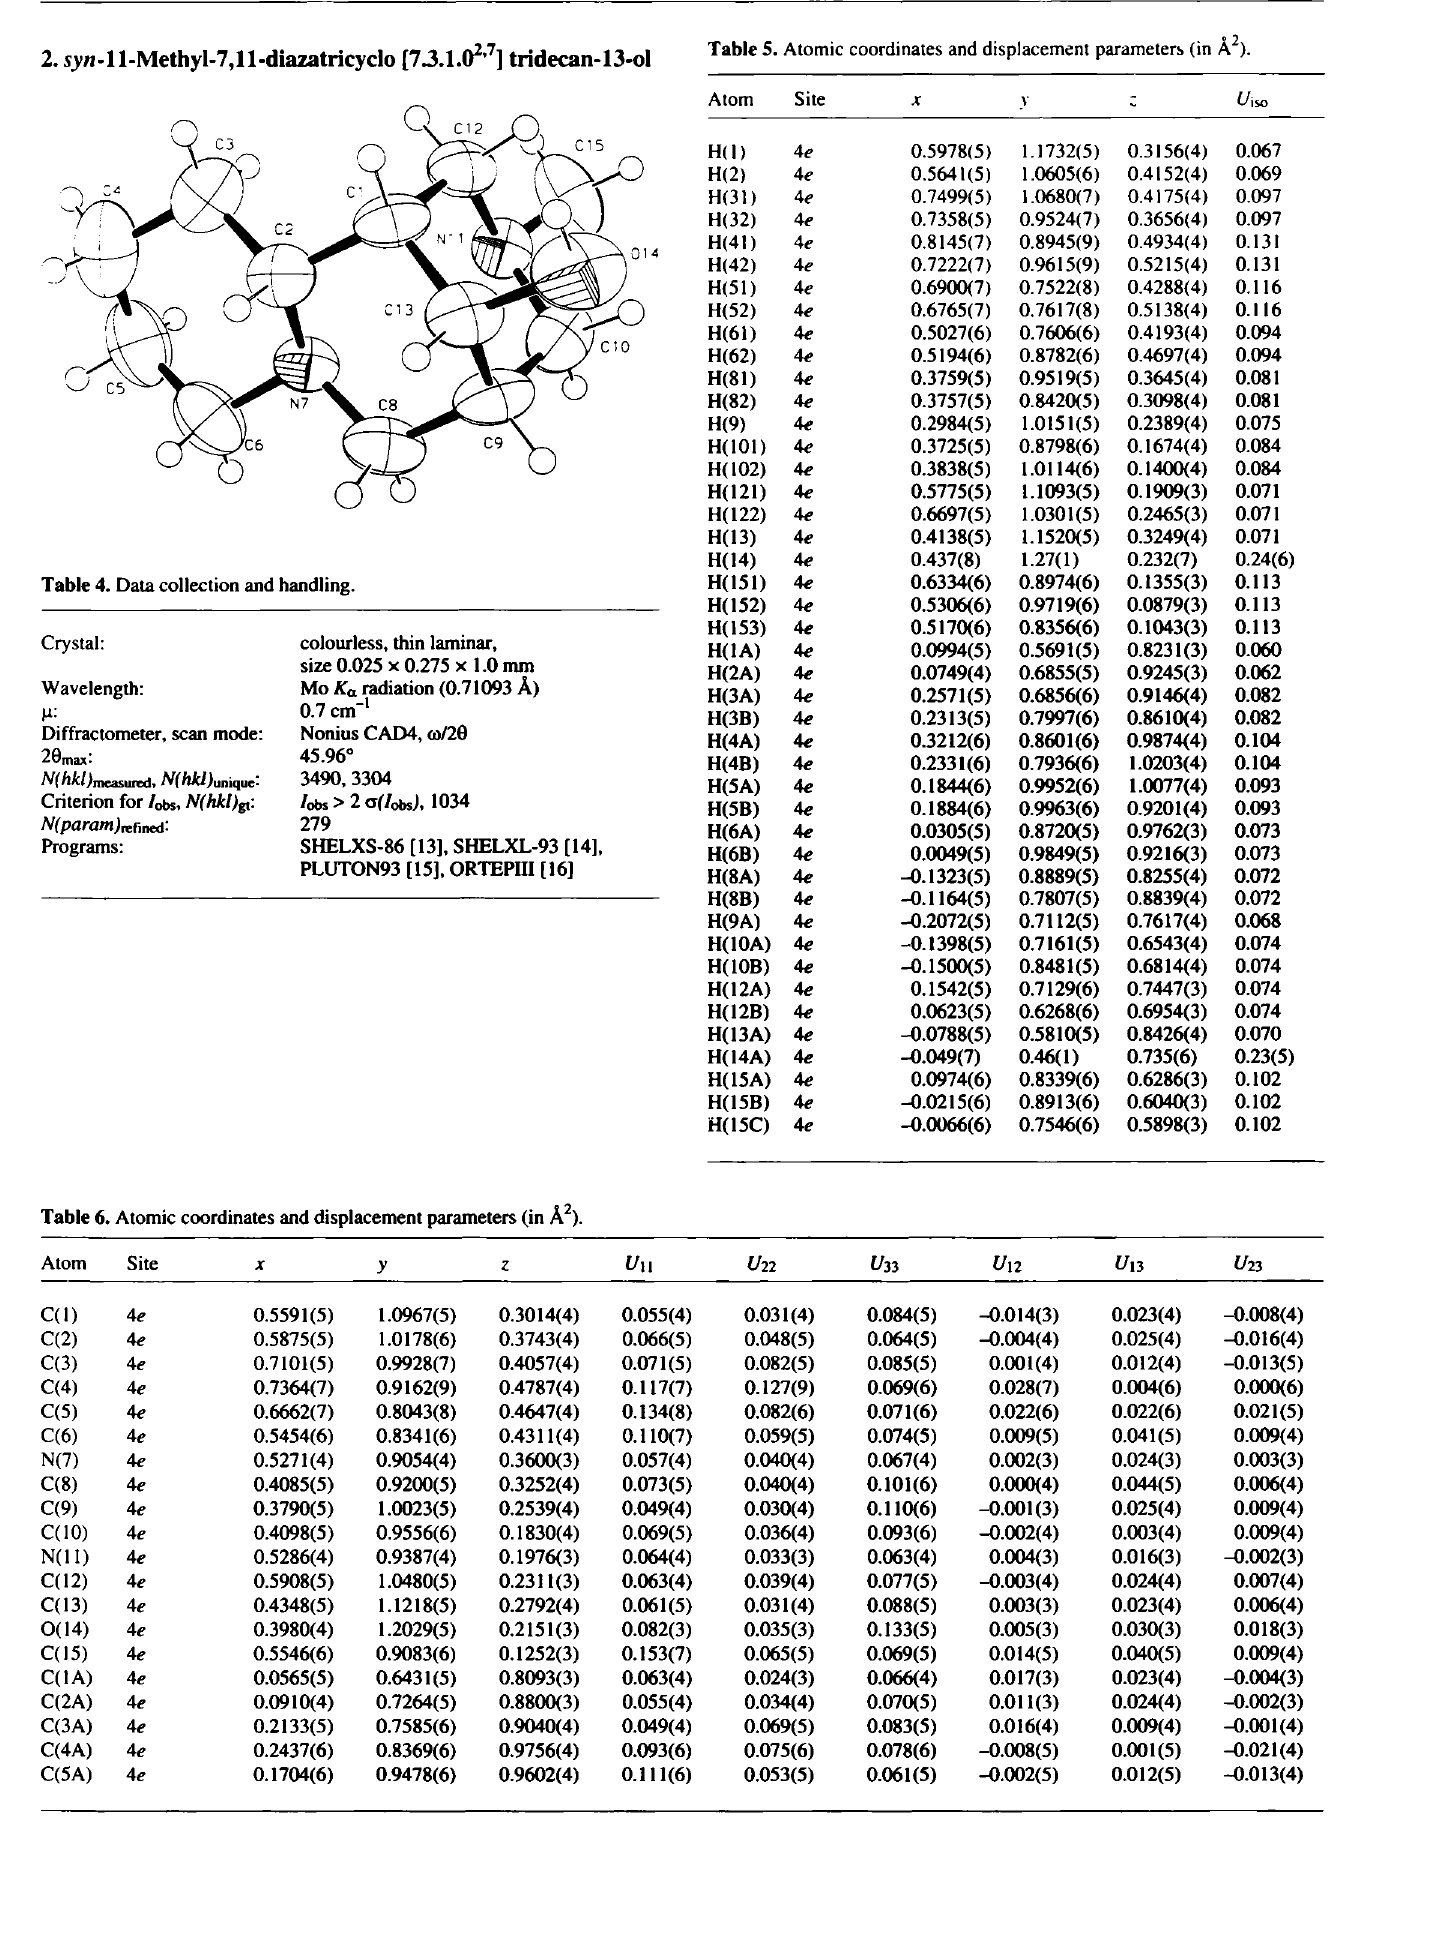
Table 5. Atomic coordinates and displacement parameters (in Ä 2 ).